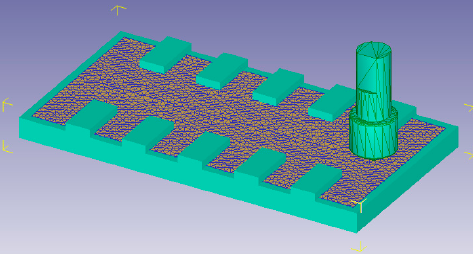
Figure 8. Workpieces with the generated mesh.